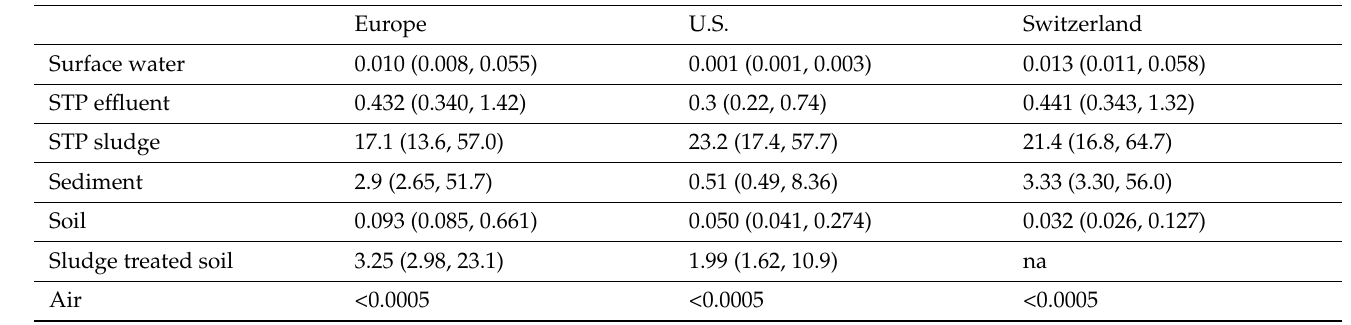
Table 1. Modeled ZnO-NP concentrations in various environmental compartments in different countries presented as mode (most frequent value) and as a range of the lower and upper quantiles (Q 0.15 and Q 0.85 ) a